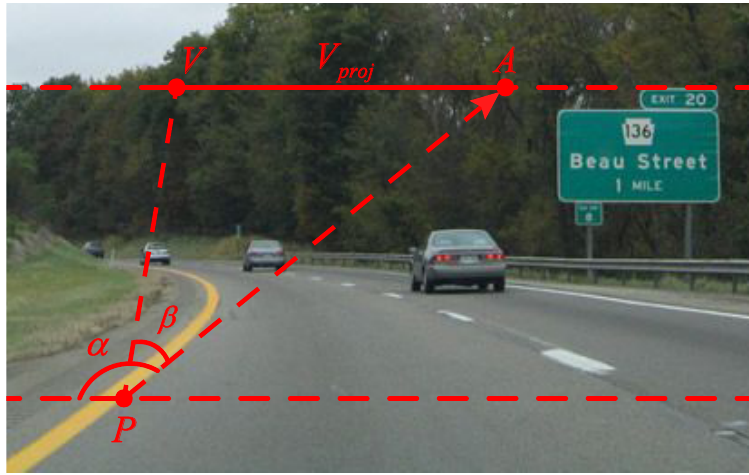
Figure 2. Illustration of the voting